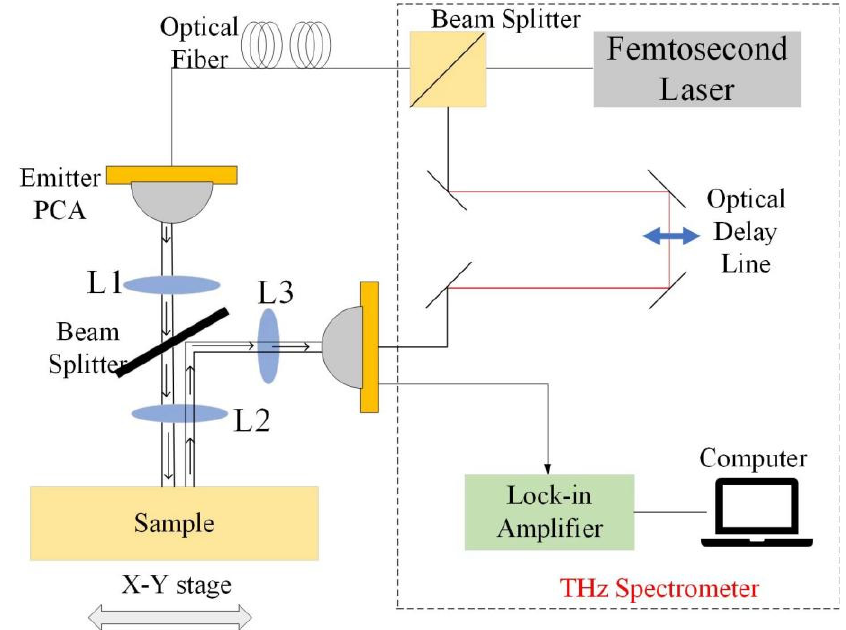
Figure 9. Schematic diagram of the THz-TDS system.